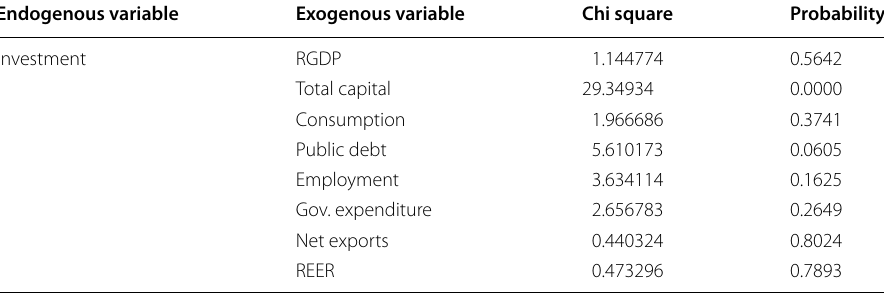
Table 11 Wald test results for Eq. (7). Source : Author’s calculations Endogenous variable